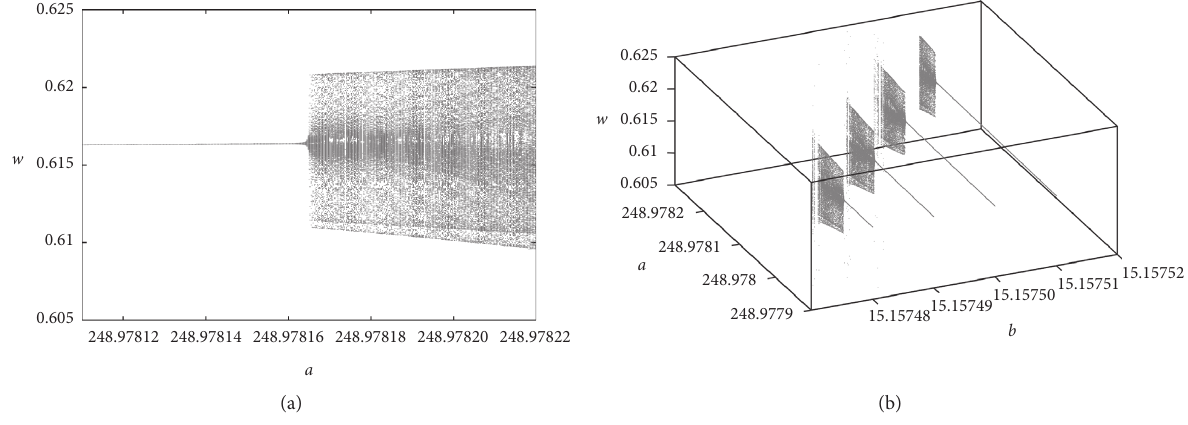
Figure 3: 1 :3 strong resonance bifurcation diagram at (0.61636576, 0.605198): (a) in ( a − w ) plane with b � 15 . 1575017 and (b) in ( b − a − w ) space.